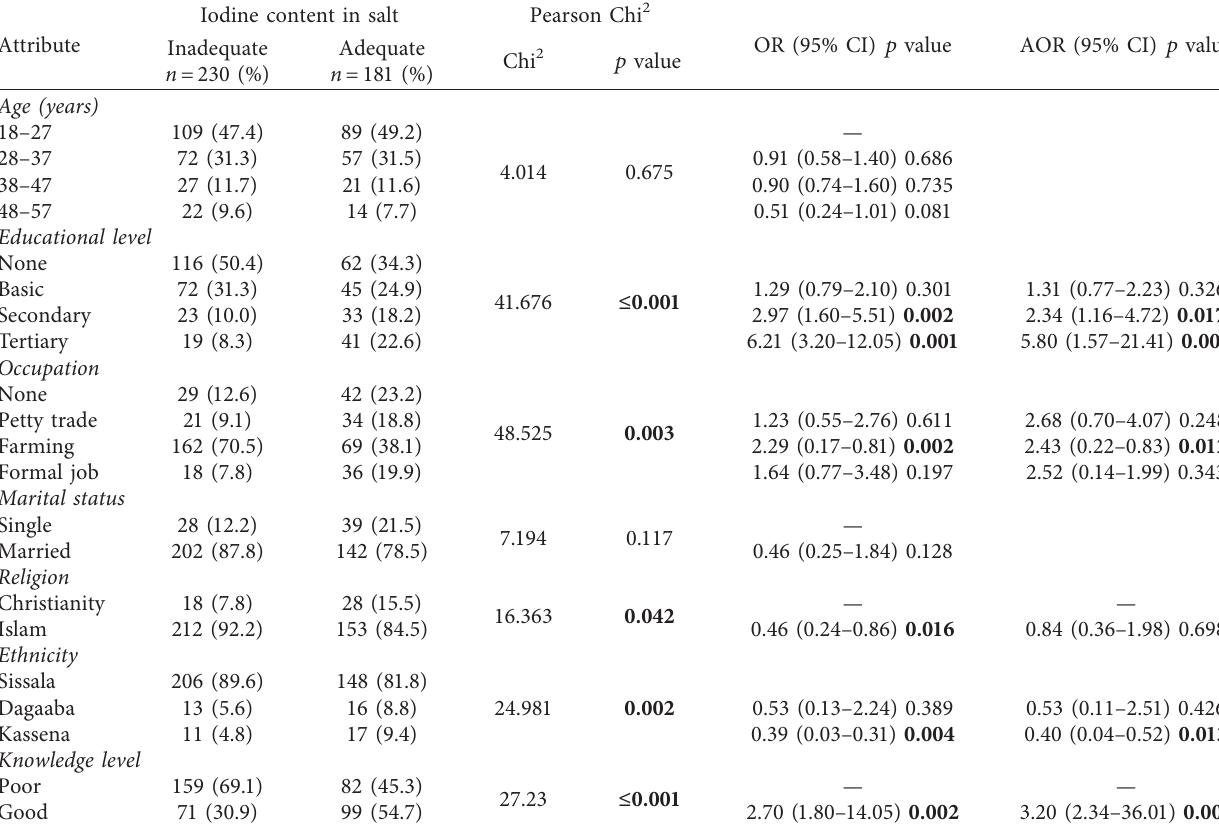
Table 3: Factors associated with iodized salt usage in the